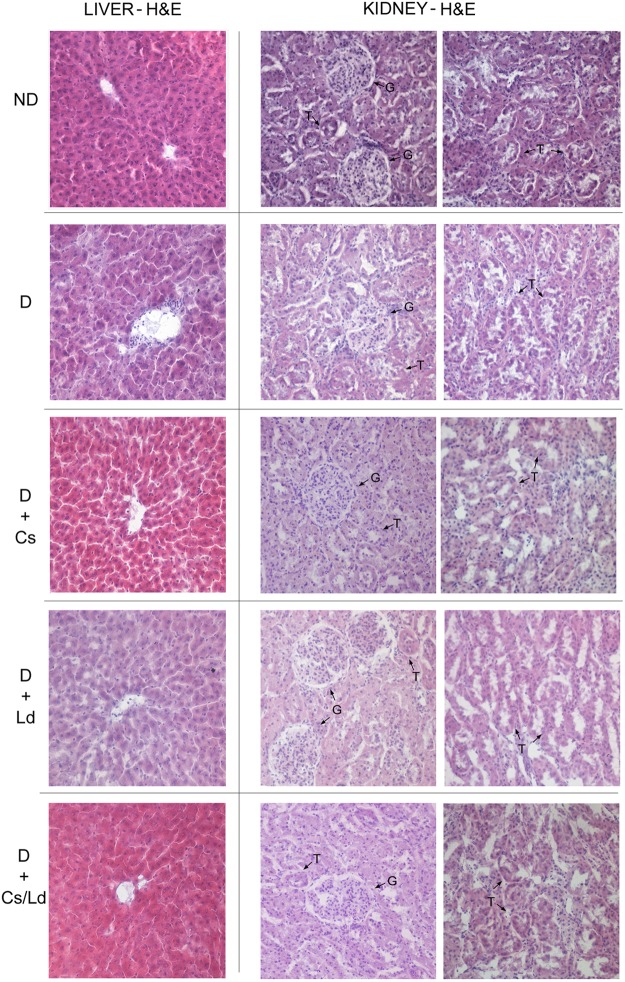
The effect of Castanea sativa, Lactarius deterrimus extracts and their combination on the histological changes in liver and kidney tissue of diabetic rats. H&E-hematoxylin and eosin staining of liver and kidney sections (magnification 20×); ND, non-diabetic control rats; D, diabetic rats; D + Cs, diabetic rats treated with C. sativa; D + Ld, diabetic rats treated with L. deterrimus; D + Cs/Ld, diabetic rats treated with the combination of C. sativa and L. deterrimus extract; G, glomerulus; T, tubules.